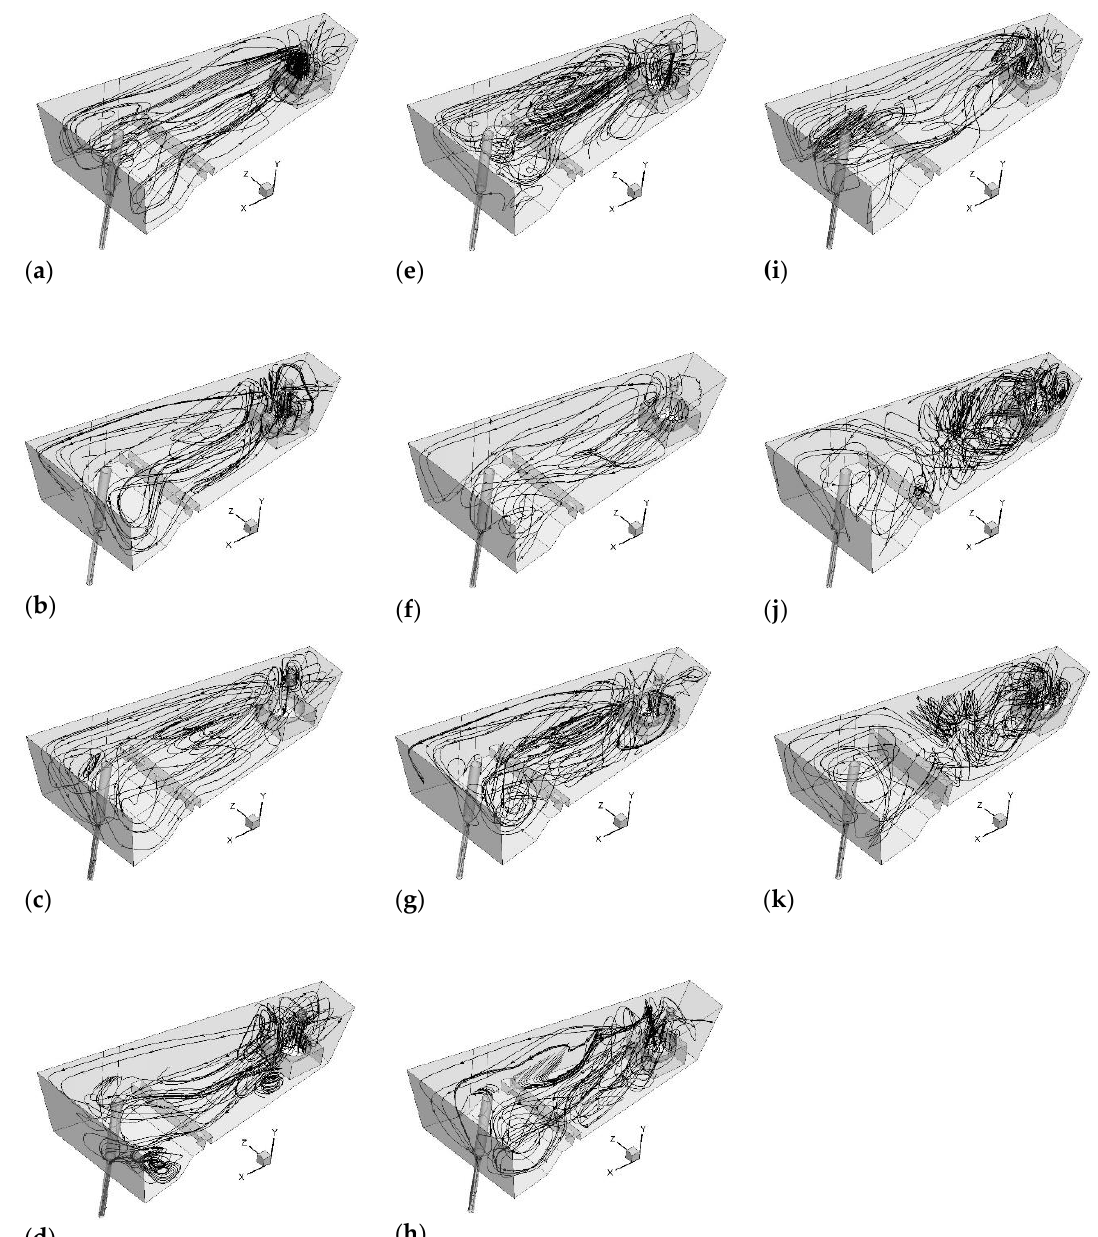
Figure 2. Liquid steel paths in the internal working volume of tundish for steady position of ladle shroud: ( a ) case No. 1, ( b ) case No. 2, ( c ) case No. 3, ( d ) case No. 4, ( e ) case No. 5, ( f ) case No. 6, ( g ) case No. 7, ( h ) case No. 8, ( i ) case No. 9, ( j ) case No. 10, and ( k ) case No. 11.